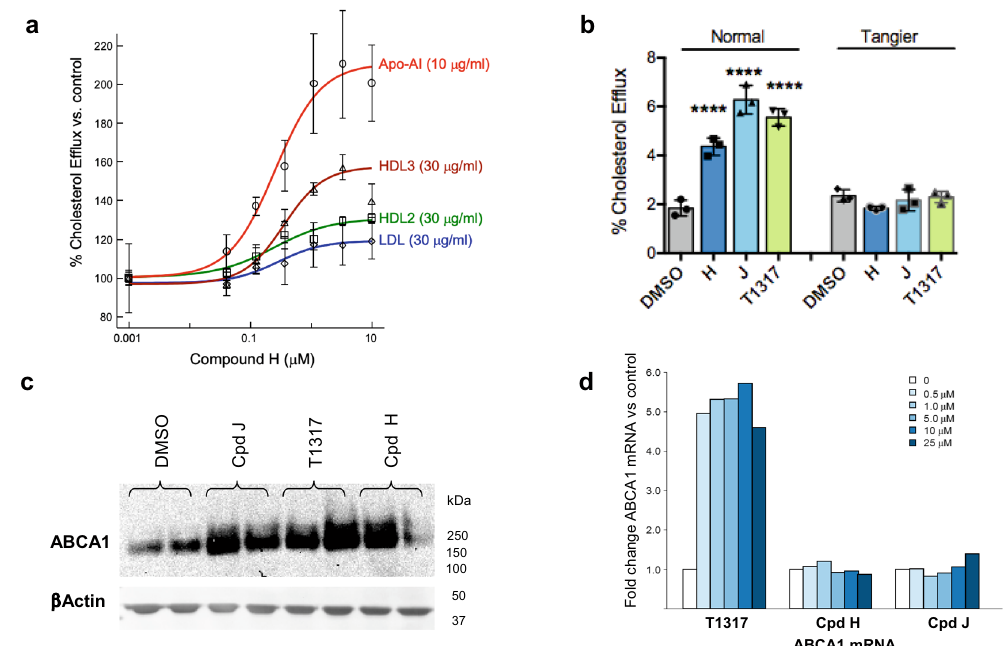
Fig. 1 Effects of 5-arylnicotinamides on ABCA1-mediated cholesterol ef fl ux. a Concentration-response of Cpd H on cholesterol ef fl ux from human THP1 macrophages to different extracellular apolipoprotein acceptors. Data are represented as the mean ± SD from three independent experiments. b Cholesterol ef fl ux assays were performed in normal human or Tangier (ABCA1-de fi cient) fi broblasts. Left panel, in normal fi broblasts both Cpd H and Cpd J (10 μ M) increased cholesterol ef fl ux to apoAI. Right panel, none of the test agents had an effect on cholesterol ef fl ux to apoAI or other lipoprotein acceptors in fi broblasts genetically de fi cient for ABCA1. Data expressed as the mean ± SD from three independent experiments. Groups were compared to DMSO control using One-way ANOVA, (F(7, 16) = 76.4), followed by Dunnett ’ s test. P < 0.0001 (****) when compounds were used in normal fi broblasts. P > 0.05 when compounds were used in Tangier fi broblasts: Cpd H, P = 0.4; Cpd J, P > 0.99; T1317, P = 0.5. c Western blot for ABCA1 protein from cholesterol-loaded THP1 macrophages treated with the LXR agonist T1317 or the two ABCA1 inducers, Cpd J and Cpd H. Image representative from three independent experiments. Duplicate protein samples from separate wells were loaded for each treatment. β -Actin was used as a loading control. d Relative mRNA expression level of ABCA1 mRNA determined by quantitative real-time PCR after treatment of cholesterol-loaded THP1 macrophages for 24 h with the indicated compounds and